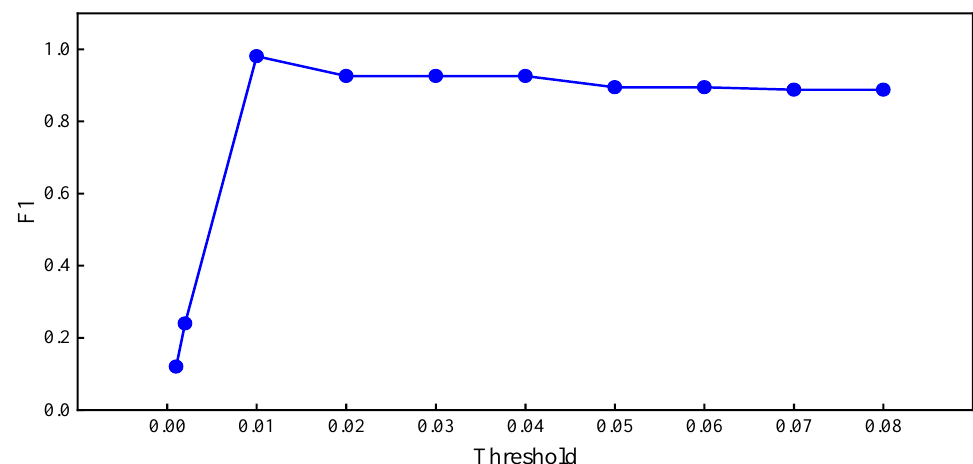
final threshold. The results of the experiments are shown in Figure 4.